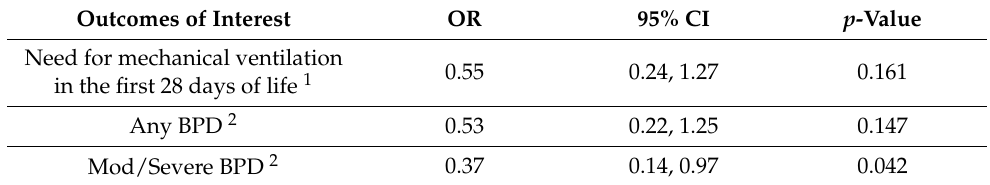
Table 3. Logistic Regression models for outcomes of interest (prophylactic high-dose vs. low-dose). Outcomes of Interest OR 95% CI p -Value